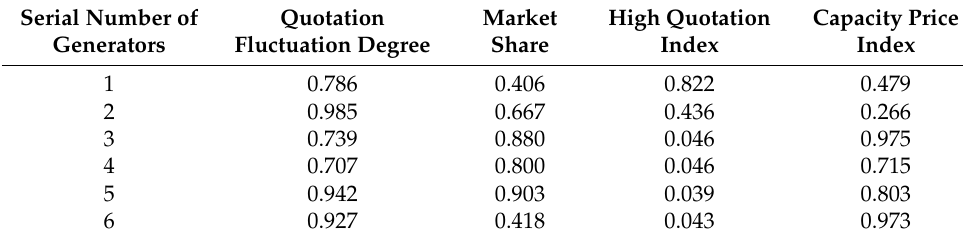
Table 7. Indicator data for generators that exercise economic withholding behavior.